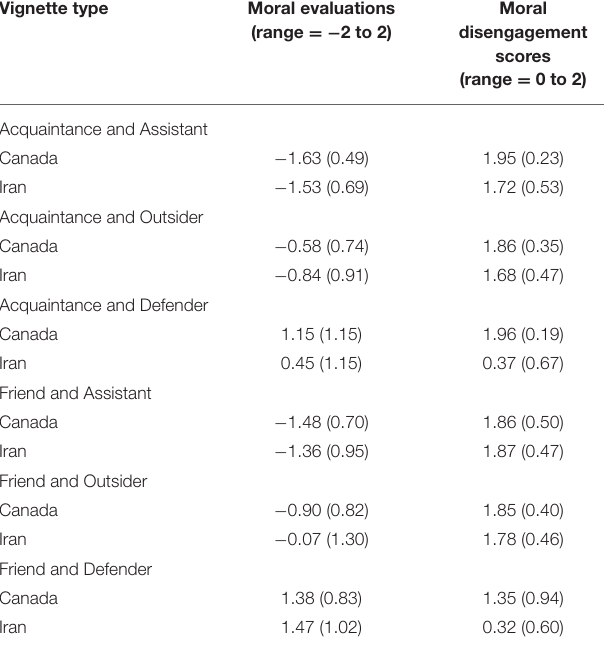
TABLE 1 | Means (SDs) for moral evaluation and moral disengagement scores according to country of origin, bystander response and bystander’s relationship to the